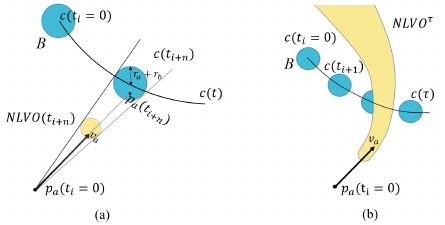
Figure 1. For a robot with current position p a ( 0 ) at origin and obstacle following trajectory c ( t ) , ( a ) shows the temporary velocity obstacle, NLVO ( t i + n ) induced for a robot due to the position of an obstacle at time t i + n . It is a disc of radius ( r a + r b ) / t i + n and its center is at c ( t i + n ) / t i + n in the robot velocity space. If the velocity of a robot is such that v a ∈ NLVO ( t i + n ) , then p a ( t i + n ) ∈ c ( t i + n ) ⊕ B . In ( b ), NLVO τ is shown as the union of its temporary components over time horizon [ 0, τ ] . If a robot velocity v a is in NLVO τ , then the collision will occur within time horizon [ 0, τ ] . NLVO: Nonlinear Velocity